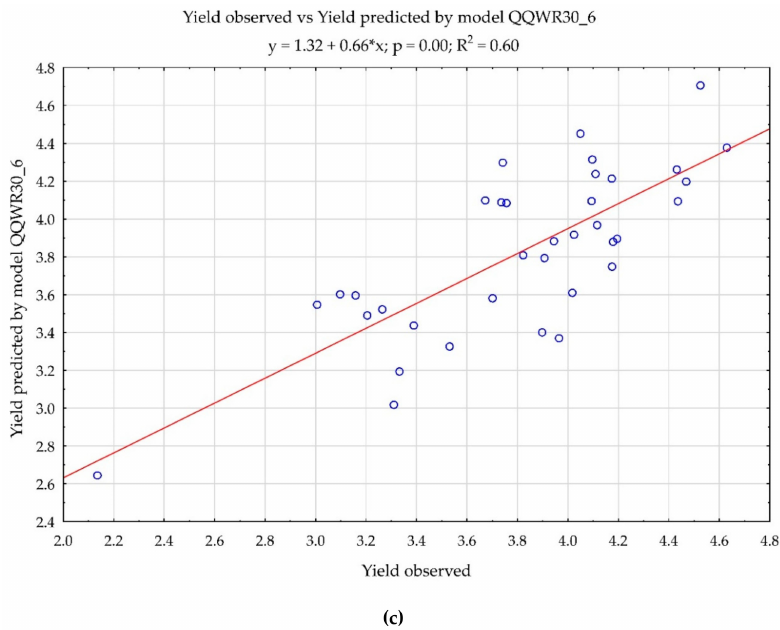
Figure 2. Relation between the observed and predicted yield (t ha − 1 ) by model: ( a ) QQWR15_4, ( b ) QQWR31_5 and ( c )